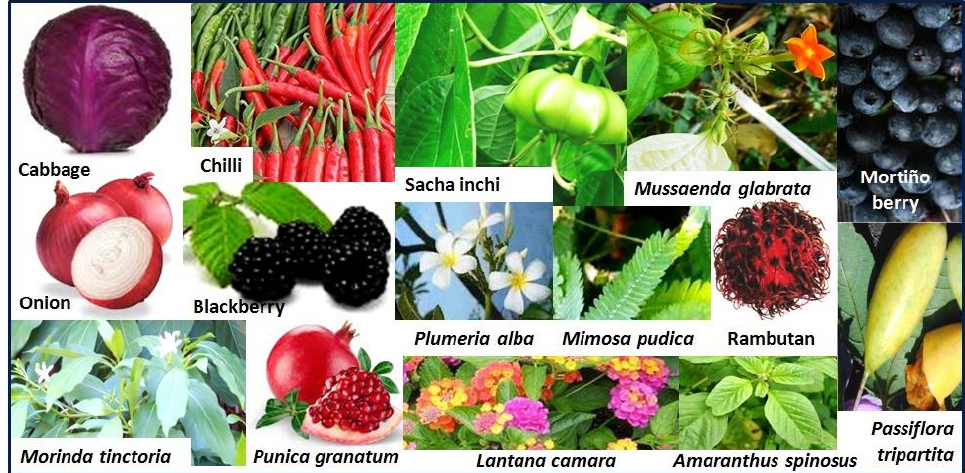
Figure 3. A variety of plant materials used for the biosynthesis of gold, silver, and iron/iron oxide nanoparticles for the removal of different organic dyes.